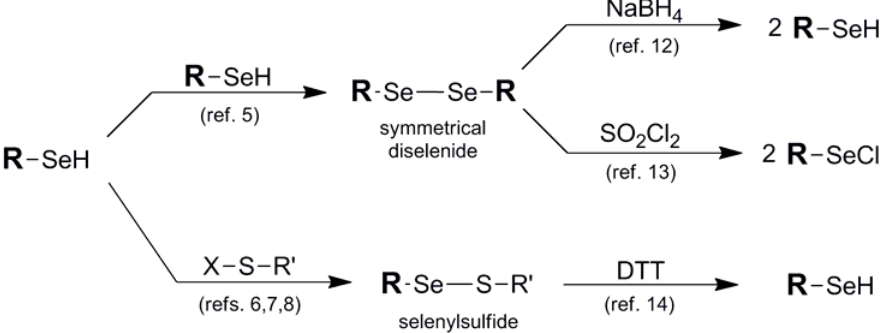
Figure 3. Synthetic routes into diselenide and disulfide protection schemes and their deprotection pathways to release their corresponding selenol